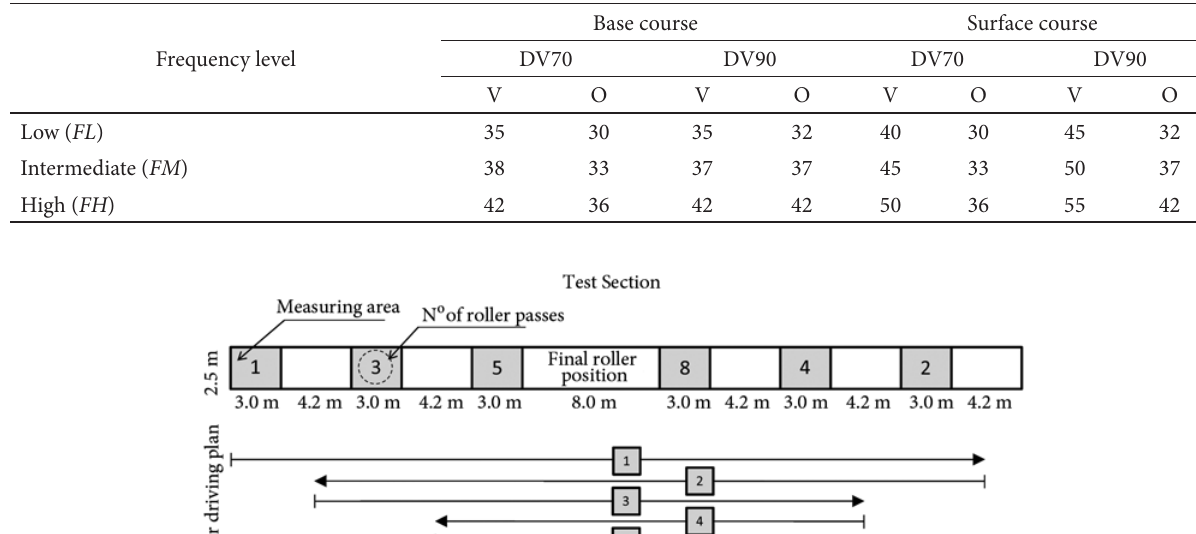
table 2. Dynamic modes frequencies for each roller, compaction mode and course in Hz